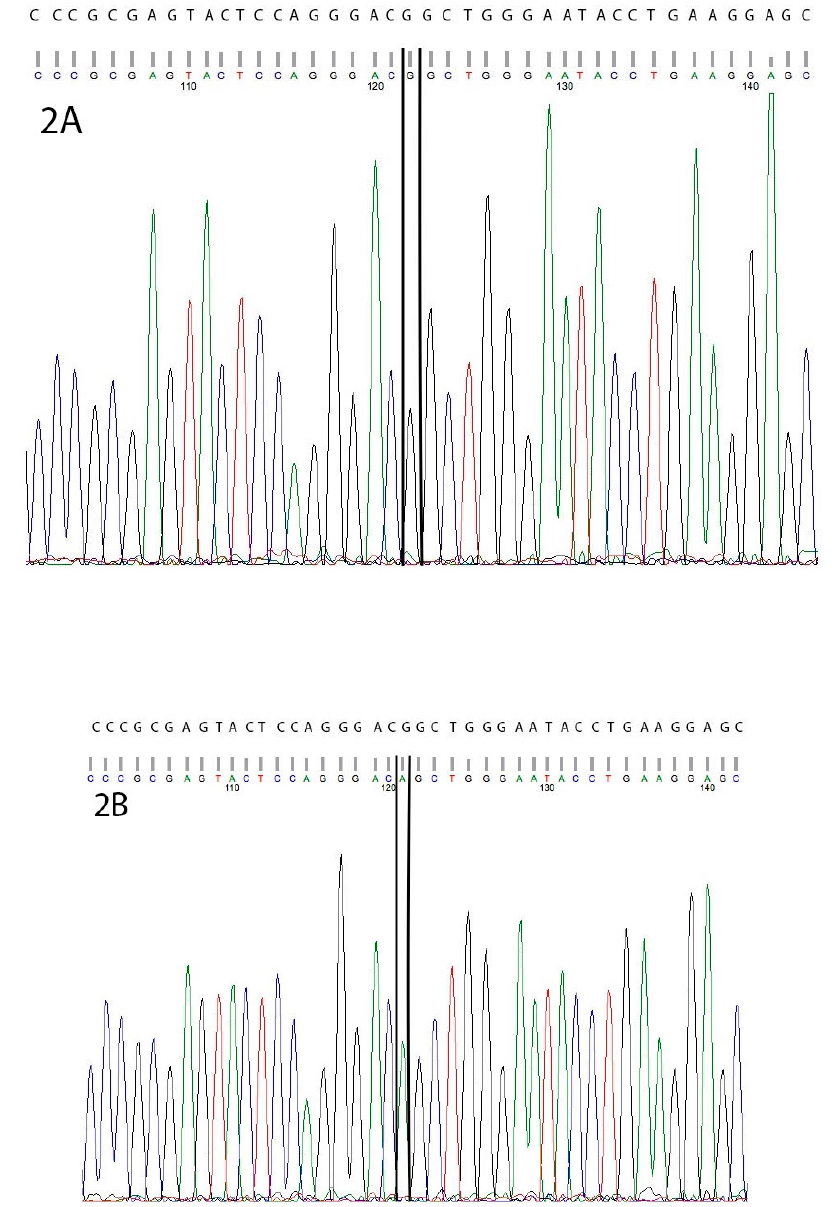
Figure 2. ( A ) Normal genetic sequence. ( B ) Sequence of a Rhodesian Ridgeback with a homozygous variant (G/A) outlined by black box. Reference sequence (ENSCAFG00000018796) alignment is above the DNA chromatogram.